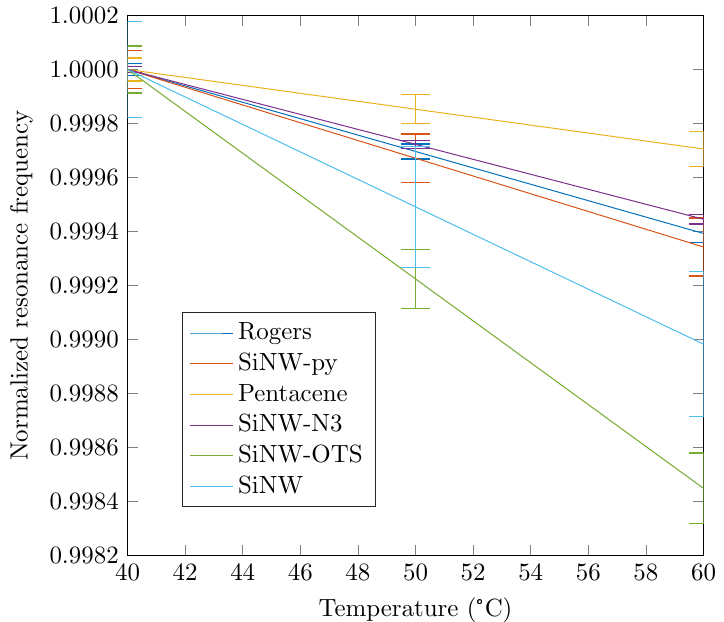
Figure 10. Normalized resonance frequencies for different temperatures at a constant humidity of RH = 60% (normalized by the initial frequency at 40 °C).